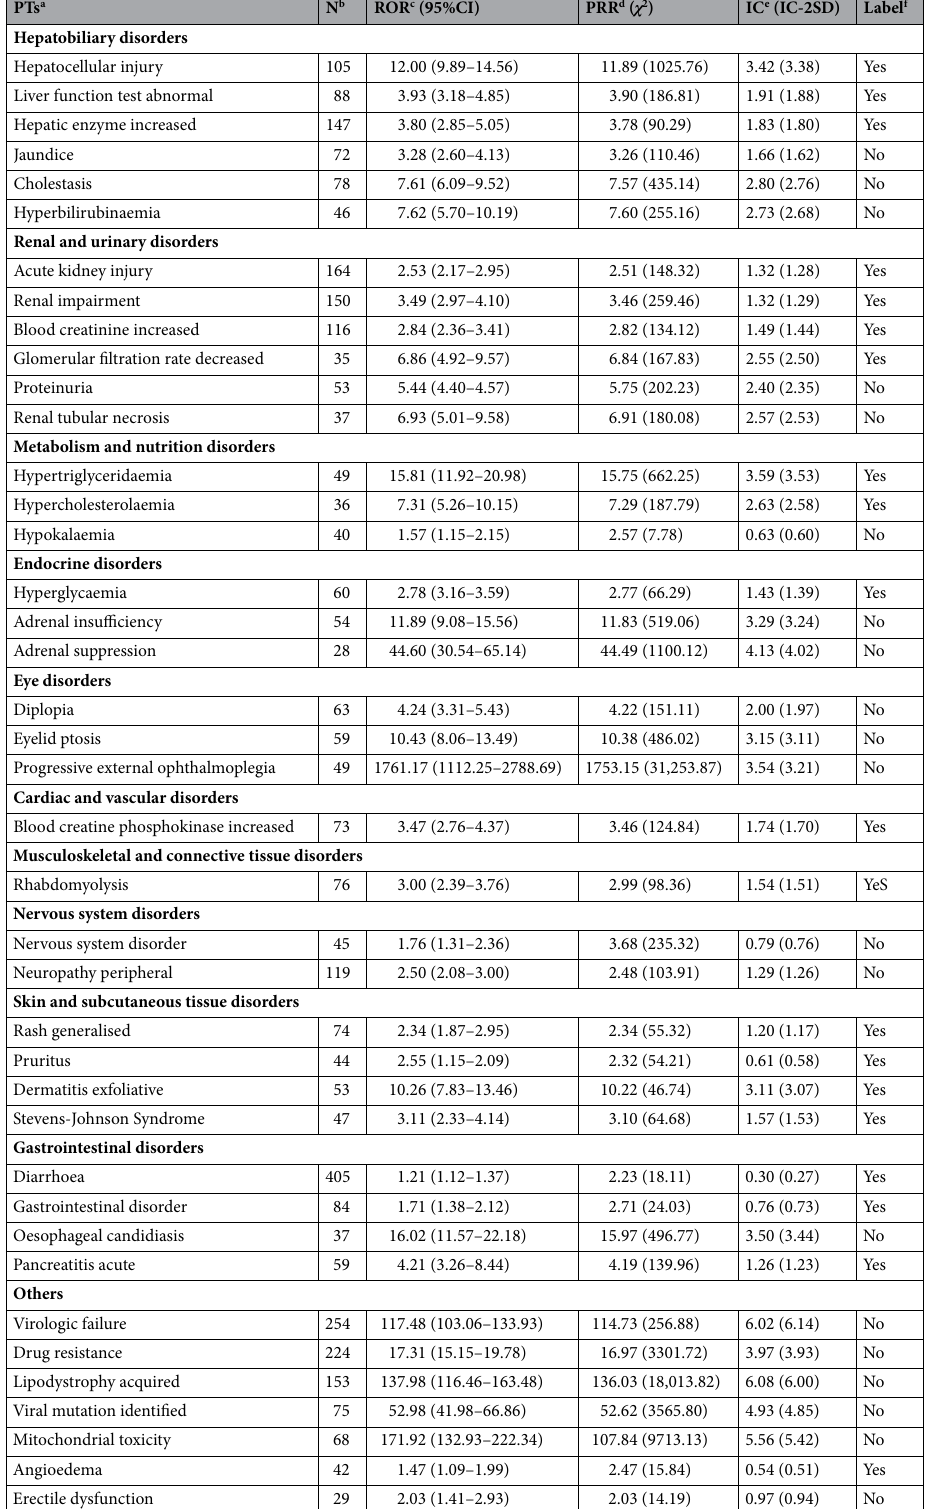
Table 4. Signal strength for darunavir and its boosted agents based on PT level in FAERS. a PT: preferred terms. b Number of patients with adverse events. c ROR reporting odds ratio. The lower limits of the 95% CI of the ROR greater than 1 indicated statistically significant RORs. d PRR proportional reporting ratio. PRR and χ 2 greater than 2 and 4 respectively indicated statistically significant PRRs. e Information component. The signal was statistically significant when IC-2SD > 0. f Whether adverse events are mentioned in the drug label or